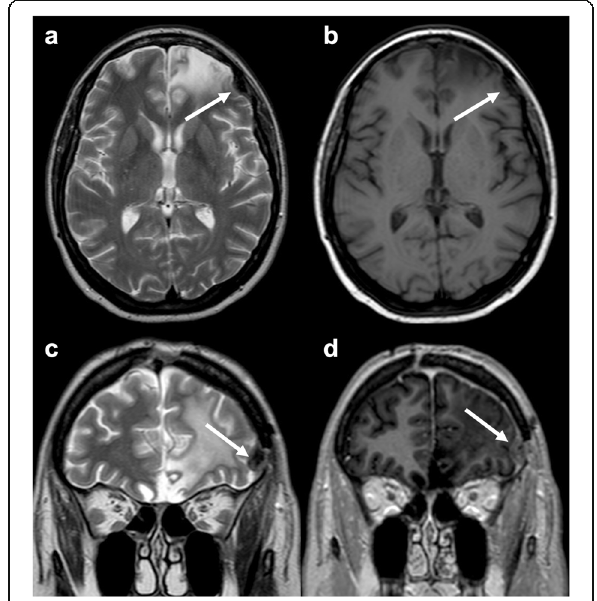
Fig. 3. Bone wax. Axial T2-weighted ( a ) and T1-weighted ( b ) and coronal T2-weighted ( c ) and post-contrast T1-weighted ( d ) images depicting burr hole bone wax, hypointense on both T1- and T2- weighted sequences (arrow in a , b , and c ). Reactive enhancement is evident on post-contrast T1-weighted image (arrow in d )